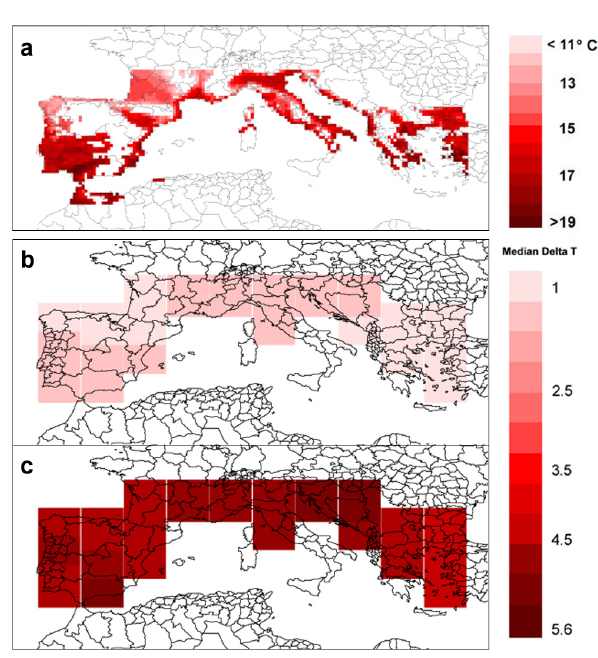
Fig. 1. Spatial distribution of present-day (1961–1990) mean tem- perature over the period April, May, June (a) , and 50th percentile of the probability distribution of temperature change projected